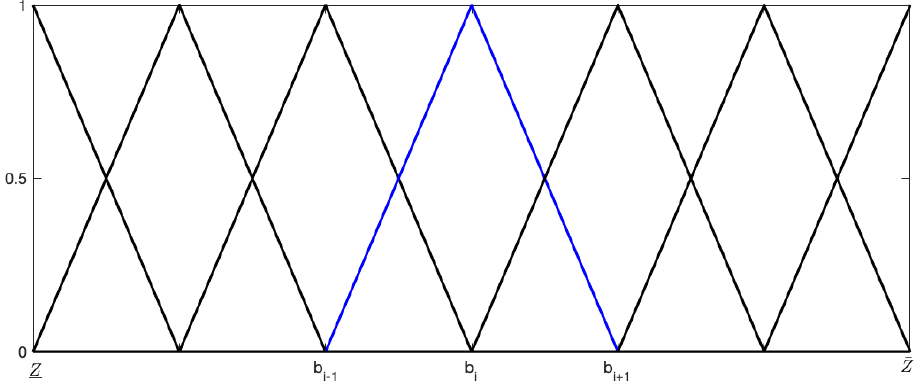
Figure 7. MOSFET degradation classes shaped by membership